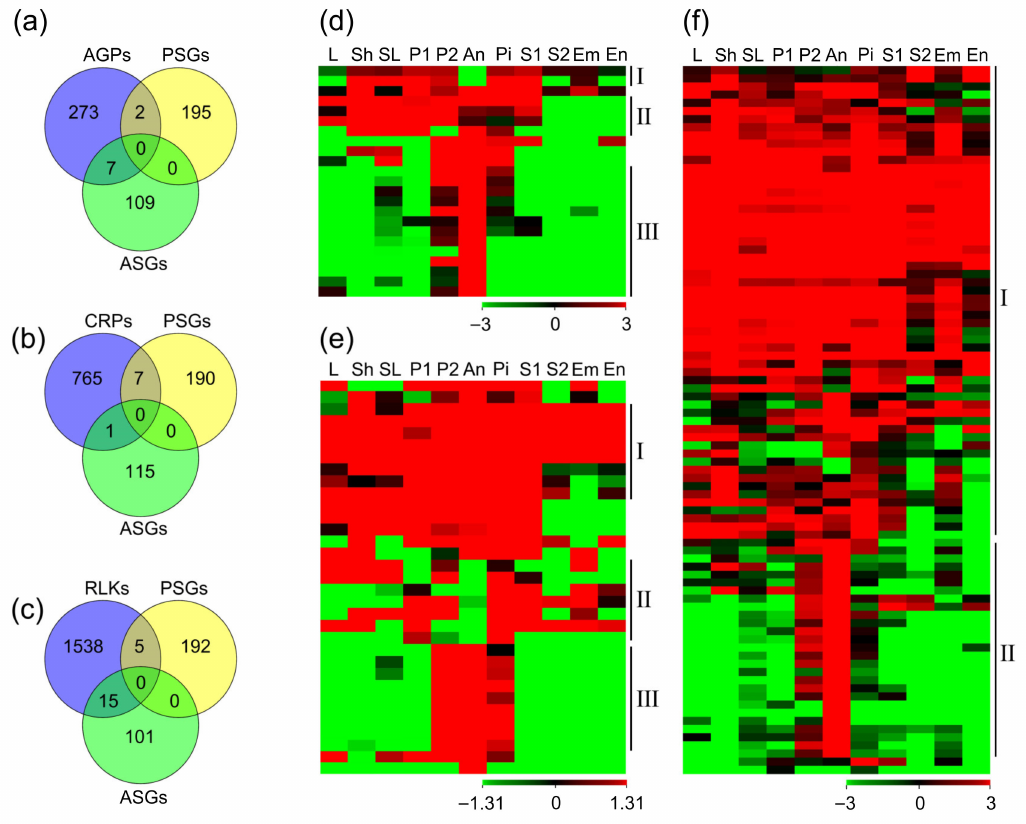
Figure 6. Venn analysis and heat map of AGP , CRP , and RLK genes in rice. ( a ) Among the 282 AGPs in rice, two genes were pistil-specific, and seven genes were anther-specific. ( b ) Among the 773 CRPs in rice, seven genes were pistil-specific, and one gene was anther-specific. ( c ) Among the 1558 RLKs , five genes were pistil-specific, and 15 genes were anther-specific. ( d ) Heat map of the 23 pollen tube-related AGPs . ( e ) Heat map of the 33 pollen tube-related CRPs . ( f ) Heat map of the 89 pollen tube-related RLKs . PSGs, pistil-specific genes that were expressed in pistil but not in anther; ASGs, anther-specific genes that were expressed in anther but not in pistil; L, 20-day-old leaf; Sh, 14-day-old seedling on the ground (shoot); SL, seedling at four-leaf stage; P1, panicle before emerging from the sheath of the flag leaf; P2, panicle after emerging from the sheath of the flag leaf; An, mature anther; Pi, mature pistil before pollination; S1, seed at 5 DAP; S2, seed at 10 DAP; Em, embryo at 25 DAP; En, endosperm at 25